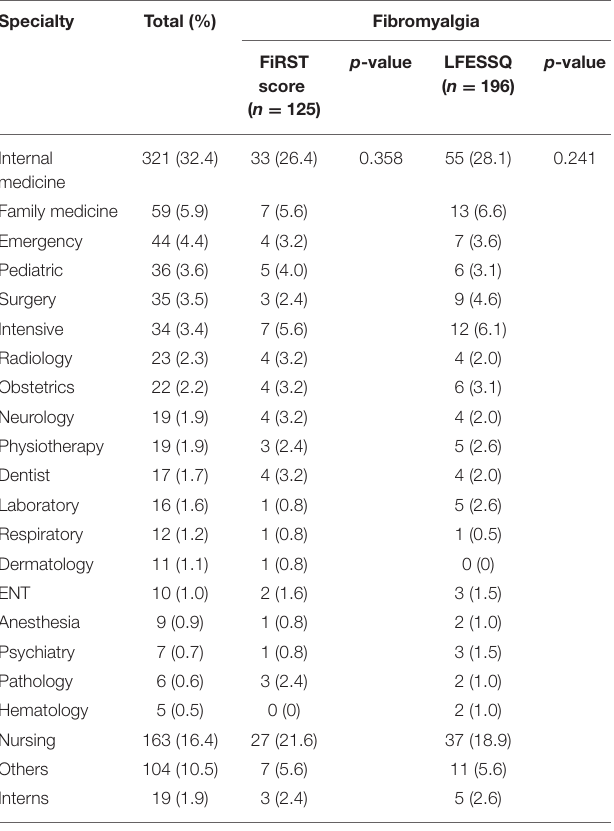
Values given in parentheses are percentages, Chi-square